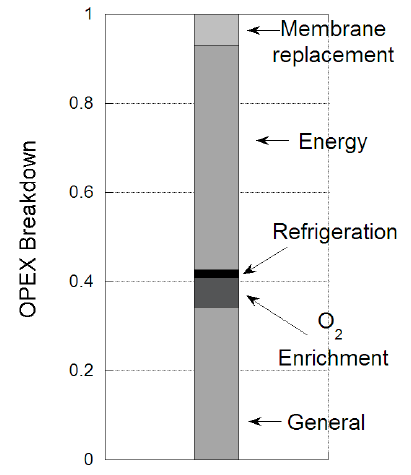
Figure 6. OPEX breakdown of NGCC post-combustion membrane capture plant.